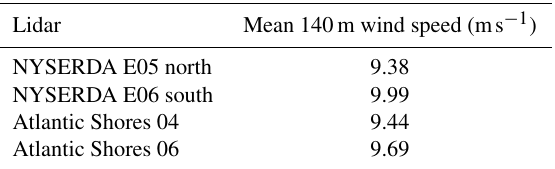
Table 2. Mean 140m mean speed from the four lidar data sets (after all the quality checks described in Sect. 2.2.1 were applied).